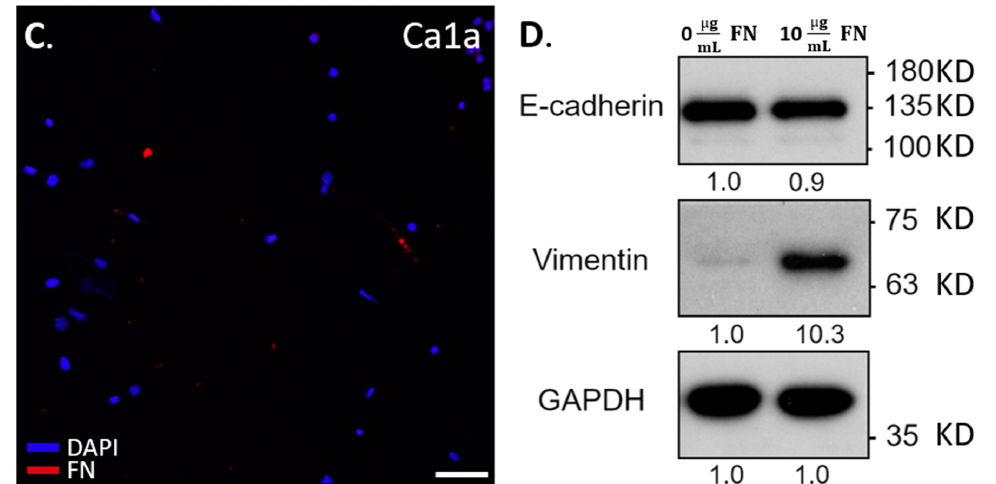
Figure 4. EMT markers in Ca1a cells upon fibronectin (FN) exposure within the well plate. The scale bar shows 100 µm. ( A ) Immunohistochemical staining for FN and DAPI on mono-cultured Ca1h cells, ( B ) Ca1h-FN30 cells, ( C ) Ca1a cells, ( D ) Immunoblotting with molecular weight markers and normalized intensity ratio, representing detection of EMT markers from Ca1a cells for FN content in their media.